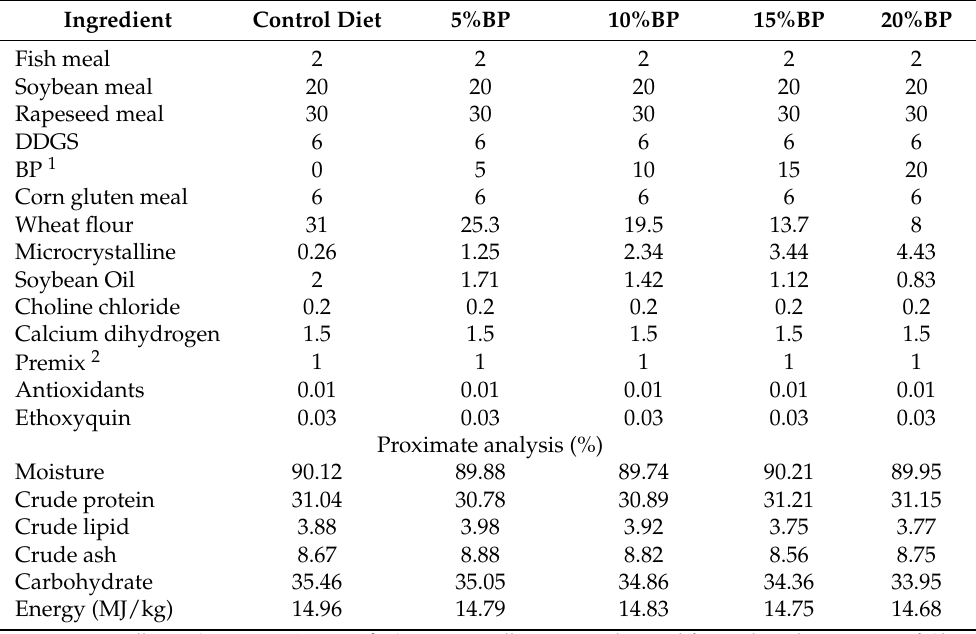
Table 1. Formulation and proximate composition of the experimental diets (dry weight,